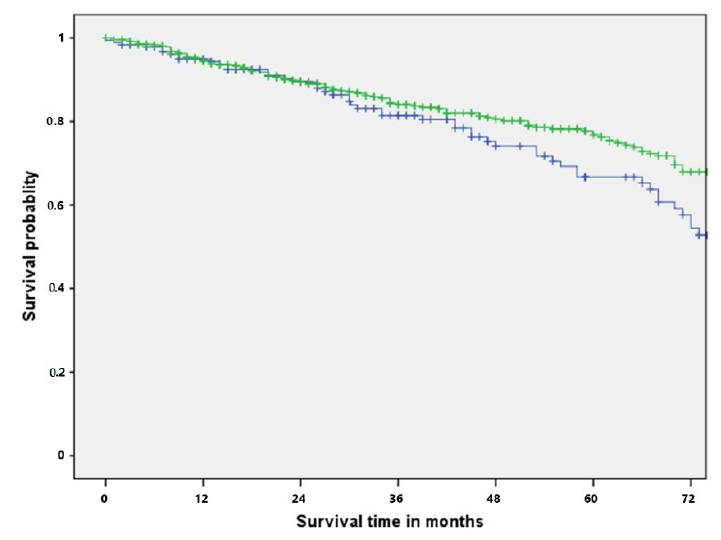
Figure 1. Overall survival rate for elderly (blue) and non-elderly (green) patients undergoing pulmonary metastasectomy.